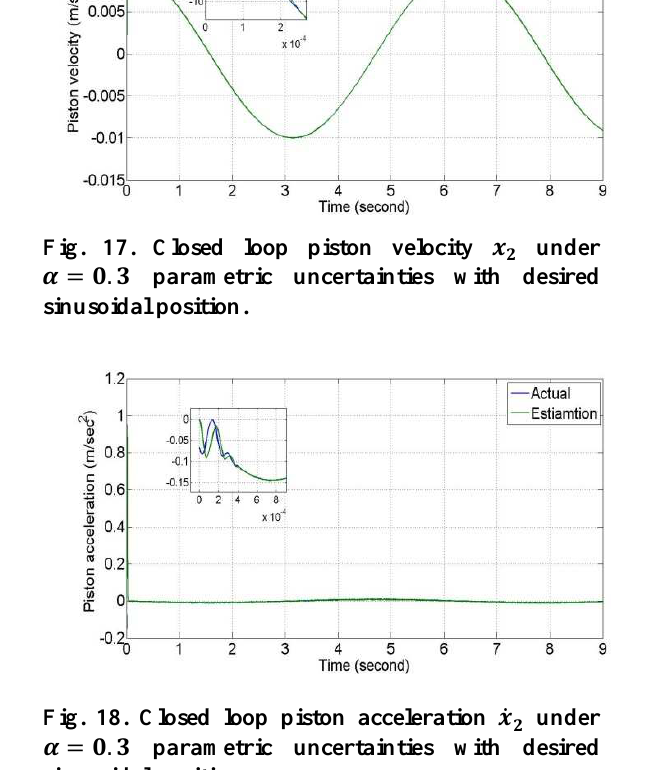
Fig. 18. Closed loop piston acceleration parametric uncertainties with desired sinusoidal position. (cid:159) = (cid:160). £